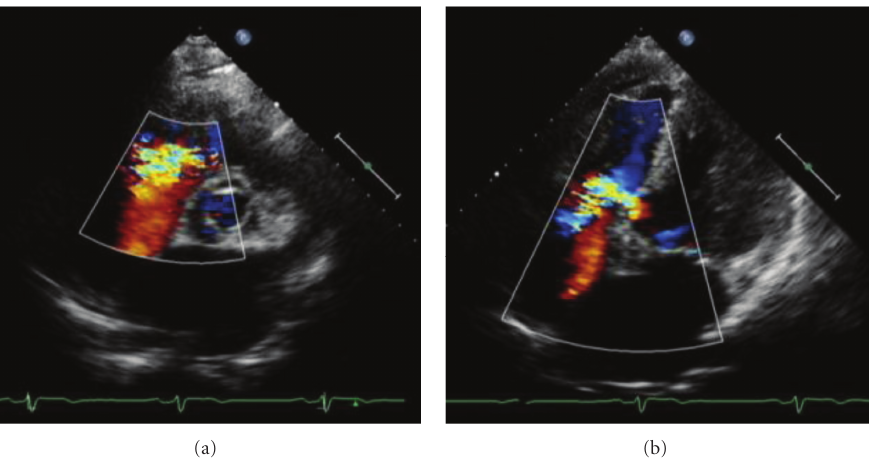
Figure 2: Echocardiography: short axis (a) and apical 4-chamber (b) view. Perimembranous ventricular septal defect L → R flow and moderate tricuspid regurgitation flow were seen.